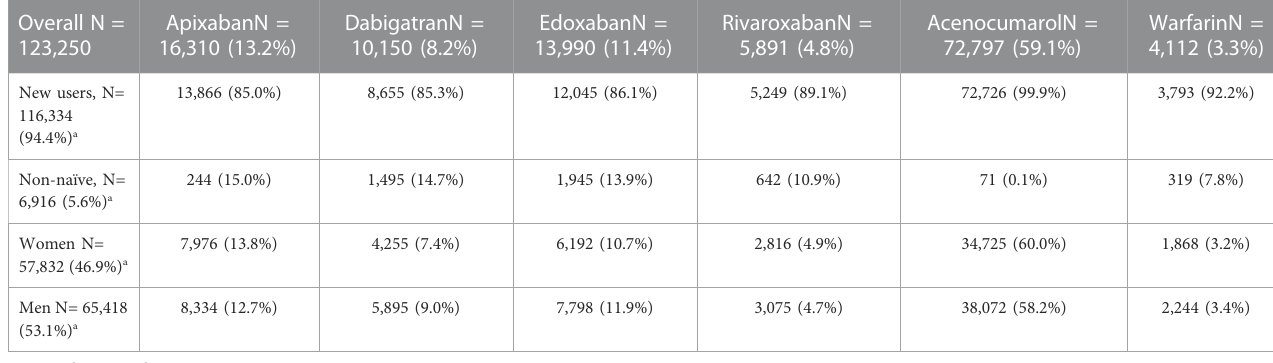
TABLE 1 Population with non-valvular atrial fi brillation initiating treatment with oral anticoagulants in 2011 – 2020. Overall N =